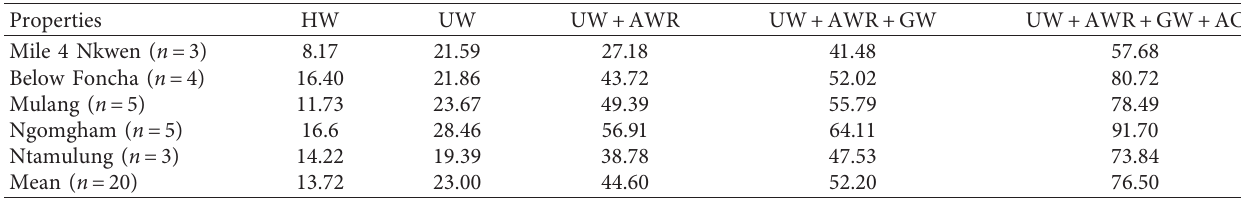
Figure 5: Mean moisture retention curve of the Gleysols from different studied sites in the Bamenda wetlands. HC: hygroscopic coefficient; WP: moisture content at permanent wilting point; FC: moisture content at field capacity. Table 8: Cumulative soil moisture contents (in % of dry soil) used to model the water characteristic curves of the Gleysols in the Bamenda